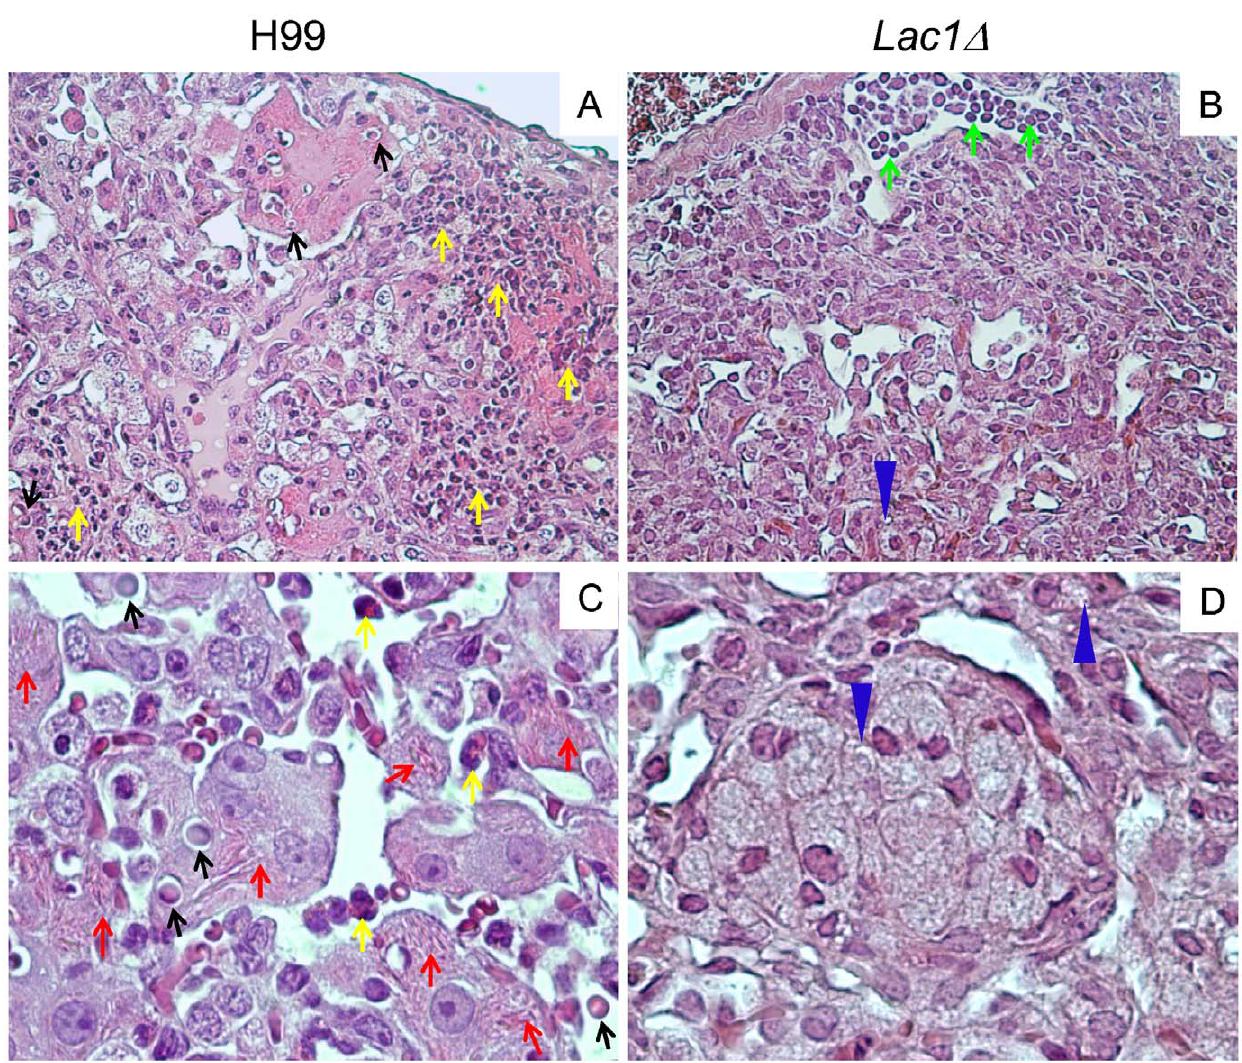
Figure 4. Effect of cryptococcal laccase on morphological patterns of pulmonary inflammation and pathological lesions in C. neoformans infected lungs. Lungs collected from H99-infected (A, C,) and lac1 D -infected (B, D,) mice were perfused with buffered formalin, fixed, and processed for histology at week 3 postinfection. Representative photomicrographs of H&E + mucicarmine-stained slides taken at 40 6 (A, B) and 100 6 (C, D) objective power. Note that sections obtained from wt-infected lungs frequently revealed macrophages harboring intracellular cryptococci encircled by large capsular halos (black arrows) as compared to lung section obtained from Lac1 D -infected lungs which revealed numerous macrophages with intracellular inclusions consistent with degraded cryptococcal organisms (blue arrows). Also, the extended macrophages in H99-infected mice are heavily laden with YM1/2 crystals (red arrows) which were not observed in lac1 D -infected lungs. Lastly, note that H99 infection leads to the accumulation of eosinophils (yellow arrow) in the lung, compared to the accumulation of lymphocytes (green arrow) in lac1 D -infected lungs.